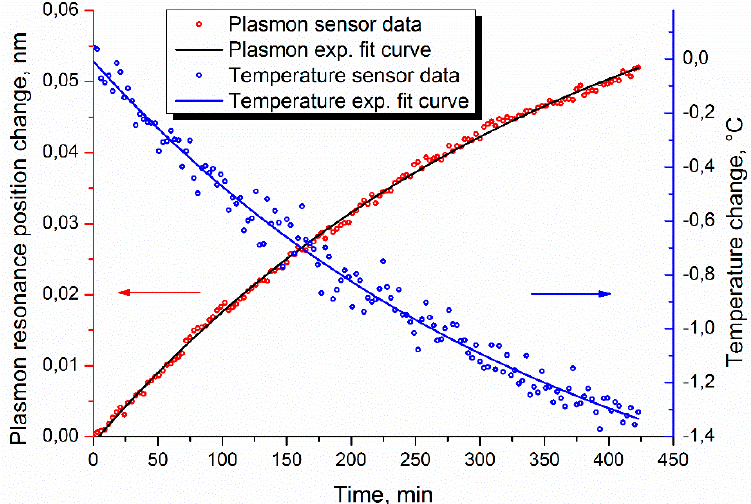
Figure 18. Experimental results for the dynamics of changes in the refractive index during the temperature drift of distilled temperature drift of distilled water.